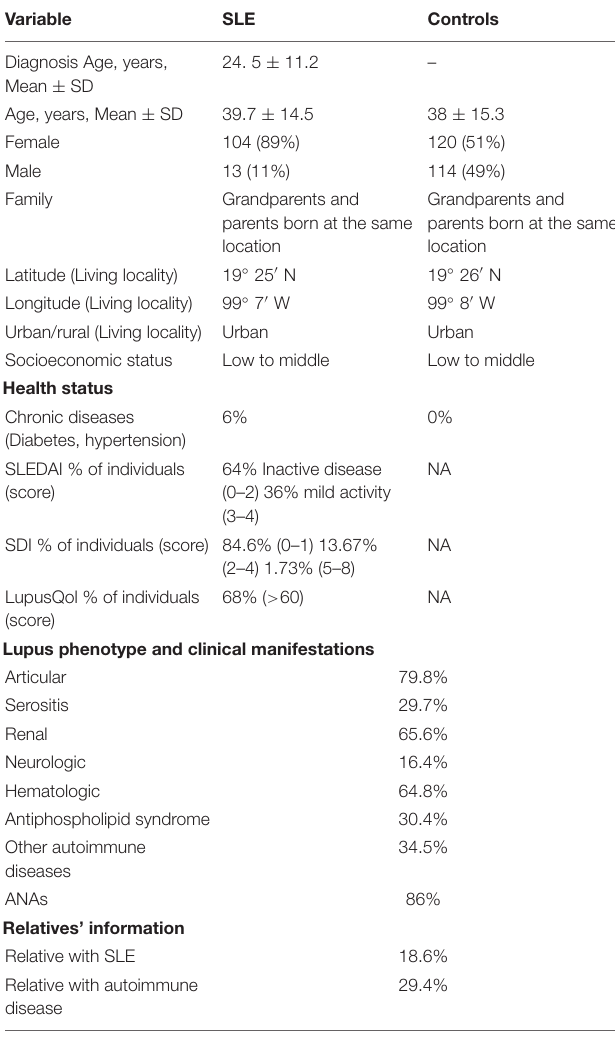
TABLE 1 | Clinical and sociodemographic information from SLE patients and